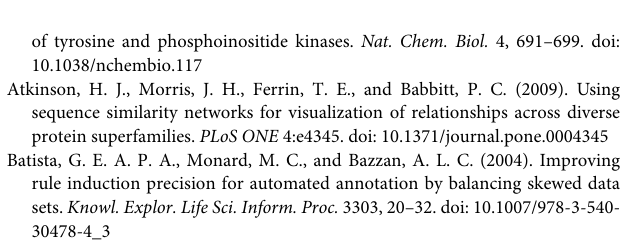
Supplementary Table 2 | Experimental drugs and their targets. Supplementary Table 3 | Criteria used for the drug categorization. Supplementary Table 4 | Computational classification of marketed drugs. Supplementary Table 5 | Drugs, Rejection Scores, and reported adverse effects. Supplementary Table 6 | Computational classification of experimental